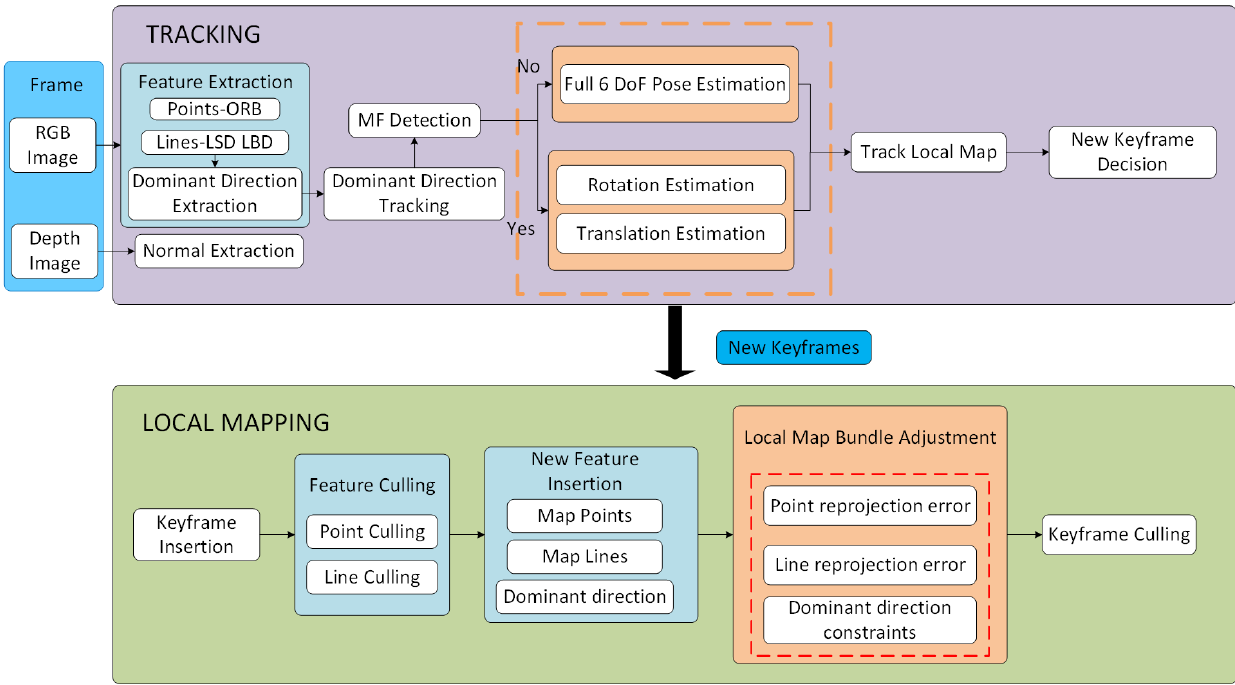
Figure 3. Overview of the proposed method.